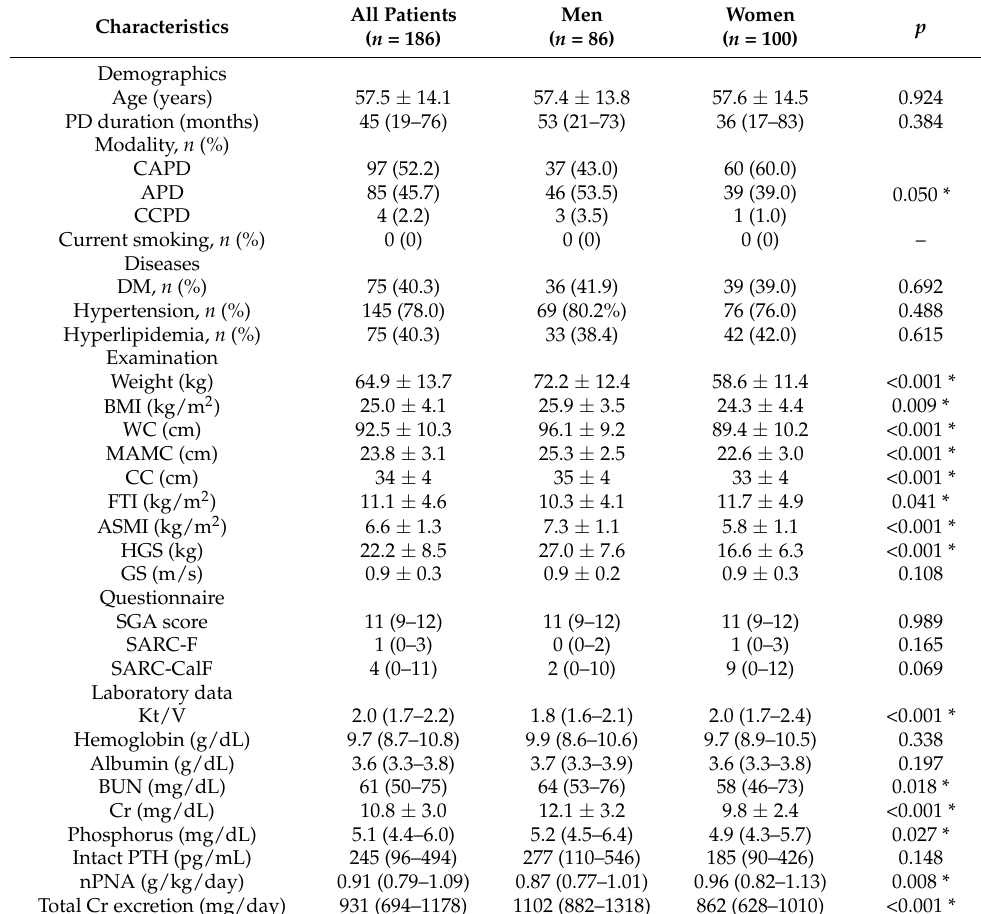
Table 2. Clinical characteristics of the 186 patients undergoing peritoneal